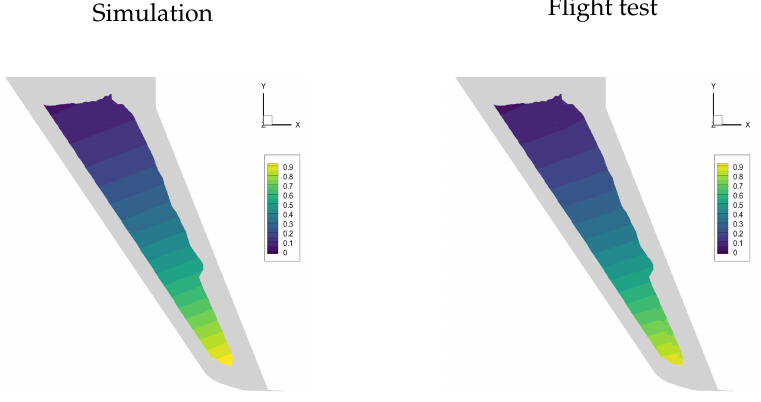
Figure 8. Magnitude of the structural deformation for the steady turn maneuver with the DLR-ATRA.